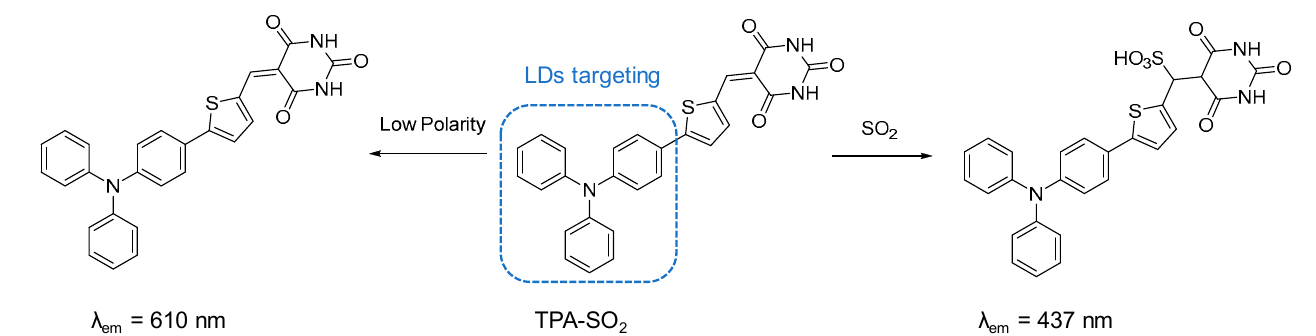
Figure 18. Response mechanism of TPA − SO 2 to polarity and SO 2 [77].